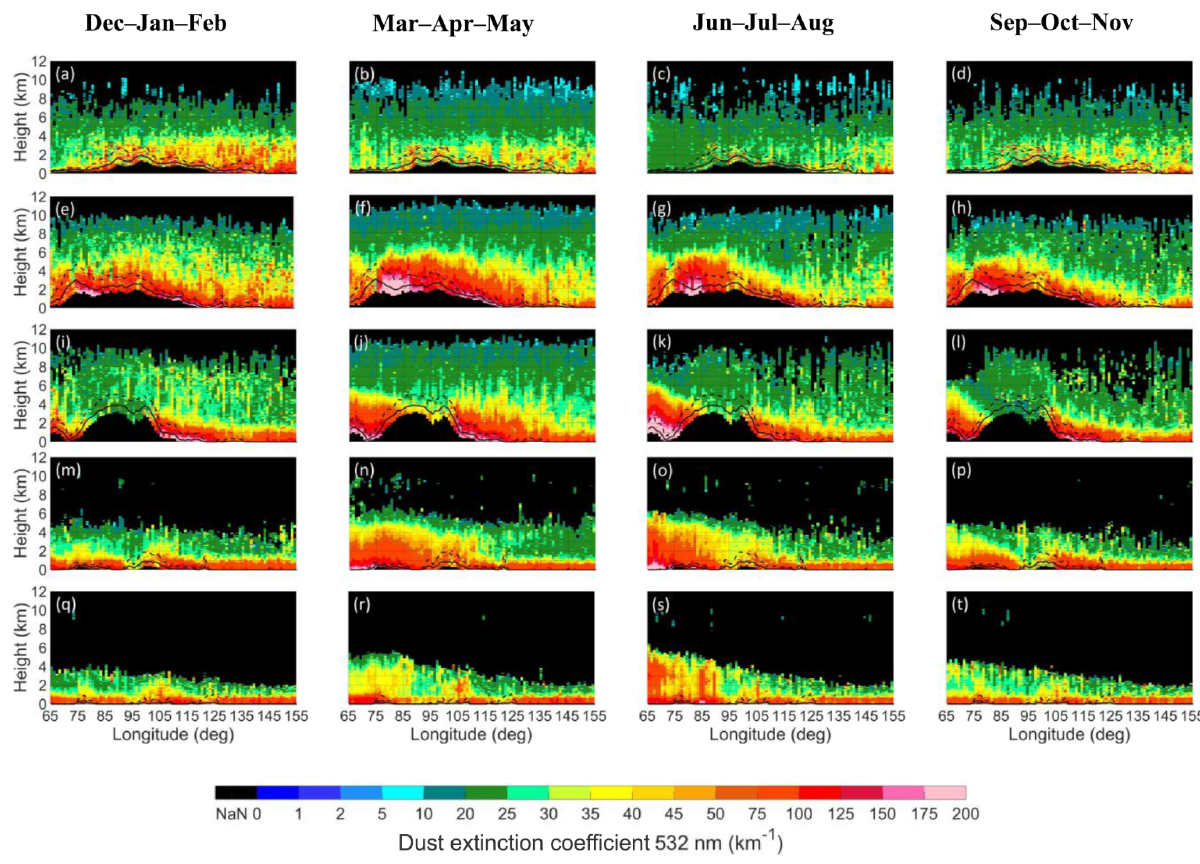
Figure 6. Zonal distribution of the conditional dust extinction coefficient (Mm − 1 ) profiles for the regions with longitude from 65 to 155 ◦ E and latitudes 45 to 55 ◦ N (a–d) , 35 to 45 ◦ N (e–h) , 25 to 35 ◦ N (i–l) , 15 to 25 ◦ N (m–p) , and 5 to 15 ◦ N (q–t) ; profiles are presented as 3-month averages: December–January–February (a, e, i, m, q) , March–April–May (b, f, j, n, r) , June–July–August (c, j, k, o, s) and September–October–November (d, h, l, p, t) . The minimum terrain elevation is denoted with black colour. The black continuous (dashed) line refers to the mean (max) elevation of the